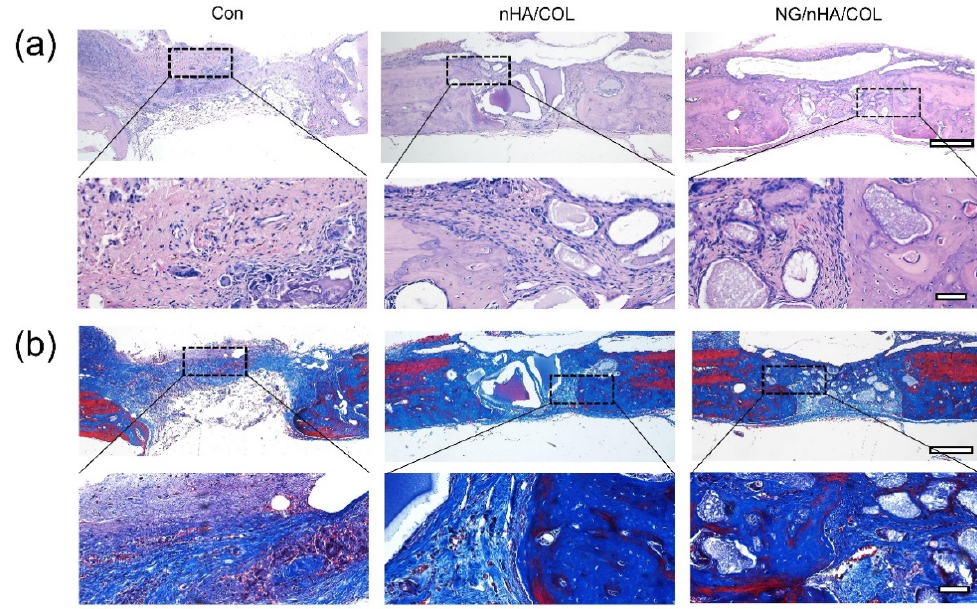
Figure 7. Histomorphological observation of bone defect areas by staining hard tissue section: ( a ) H&E staining. ( b ) Masson’s trichrome staining (scale bar: 200 µm and 40 µm).